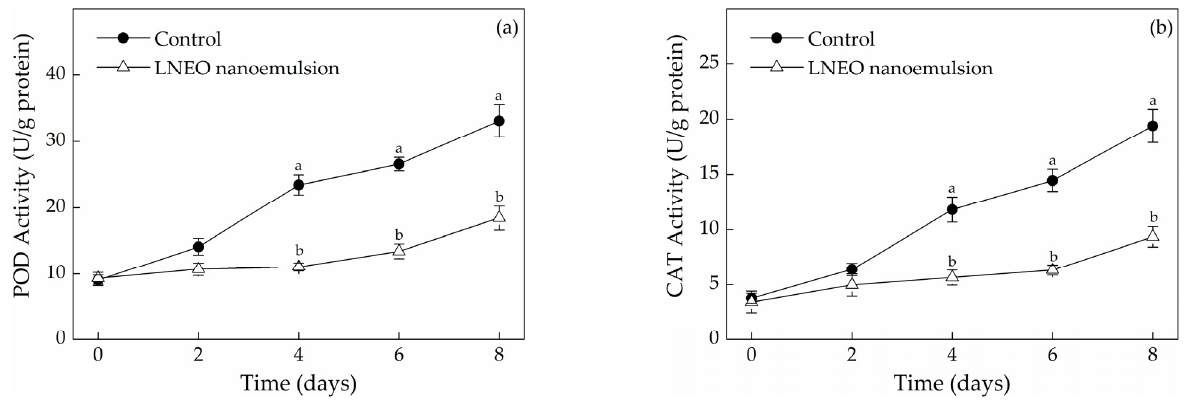
Figure 3. Effects of the LNEO nanoemulsion on activities of POD ( a ) and CAT ( b ) in fresh-cut muskmelons. Data are the mean ± standard deviation (n = 3); a, b different letters denote statistical significance.